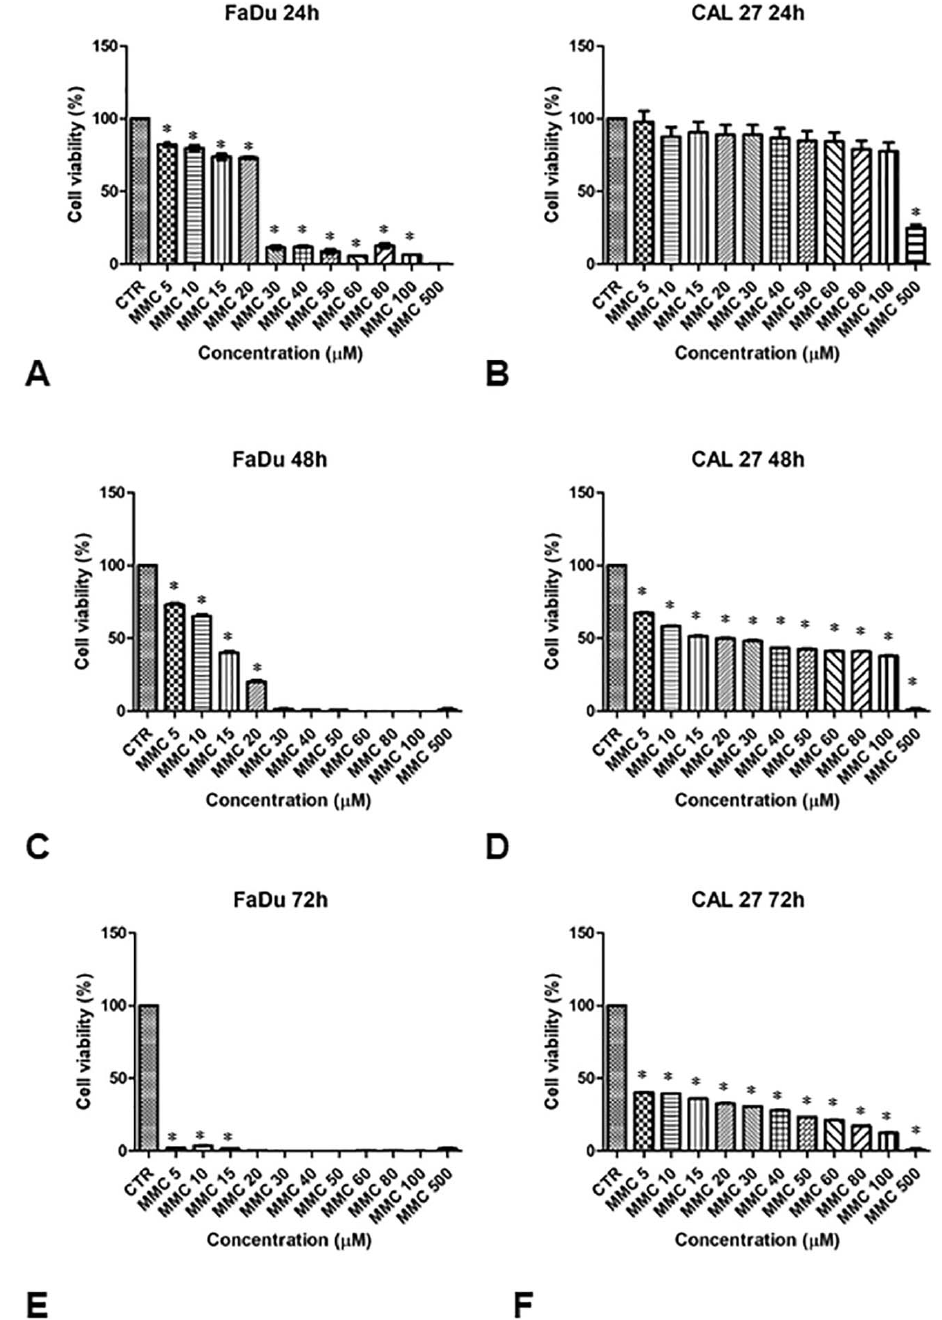
Figure 2. Analysis of the cell viability of FaDu and CAL 27 cells after treatment with mitomycin C (MMC, 5–500 µM). MMT assay was performed on FaDu cells after 24 h ( A ), 48 h ( C ), and 72 h ( E ), and on CAL 27 cells after 24 h ( B ), 48 h ( D ), and 72 h ( F ). The results obtained from three independent experiments, each in sixfold, were expressed as mean ± standard deviation, *: p < 0.05 vs. control. CAL 27 cells treated with the same MMC concentrations for 24 h, showed no significant inhibition of cell growth compared to the control cells (Figure 2B). Only at 500 µ M was cell viability approximately 30%. At 48 h of treatment, cell viability was between 65% and